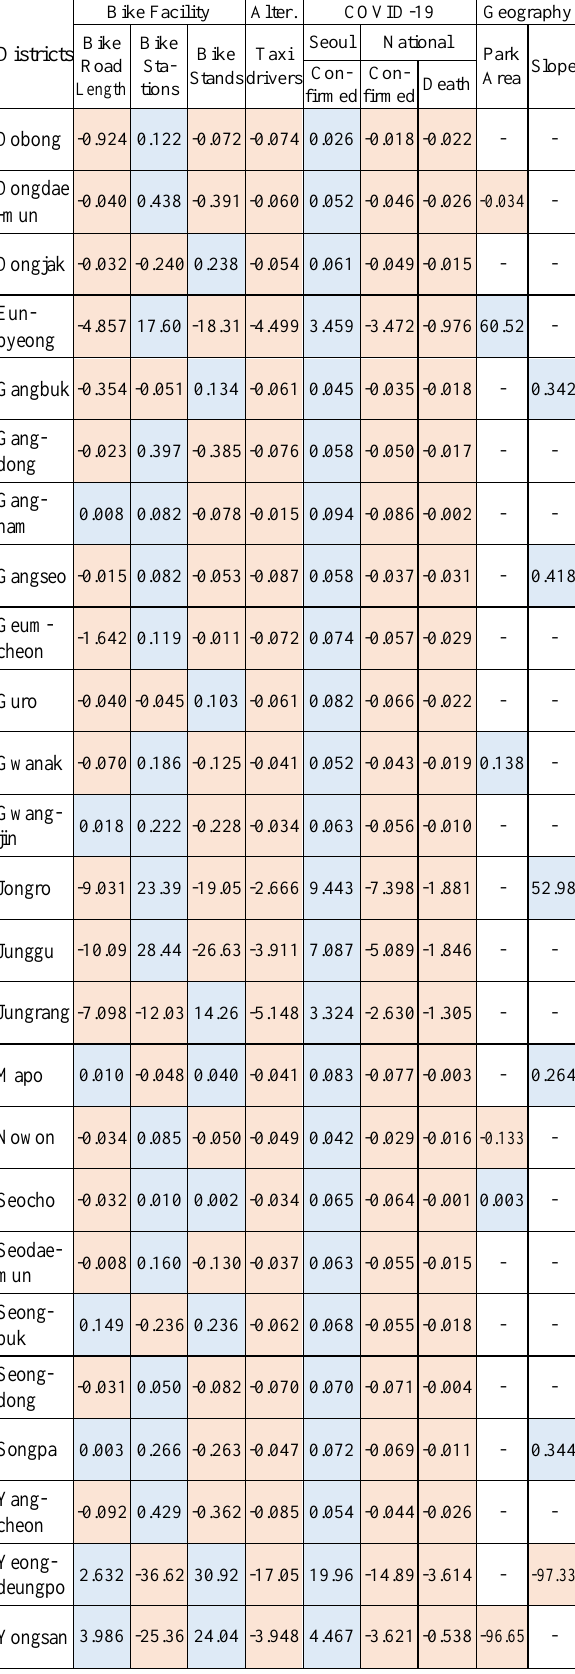
Table 2 . Estimation Results of Correlation between Bike Use and Social Environmental Data by District in Seoul